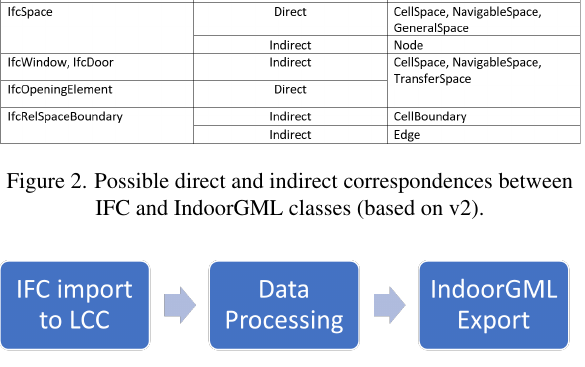
Figure 3. The three main steps of our